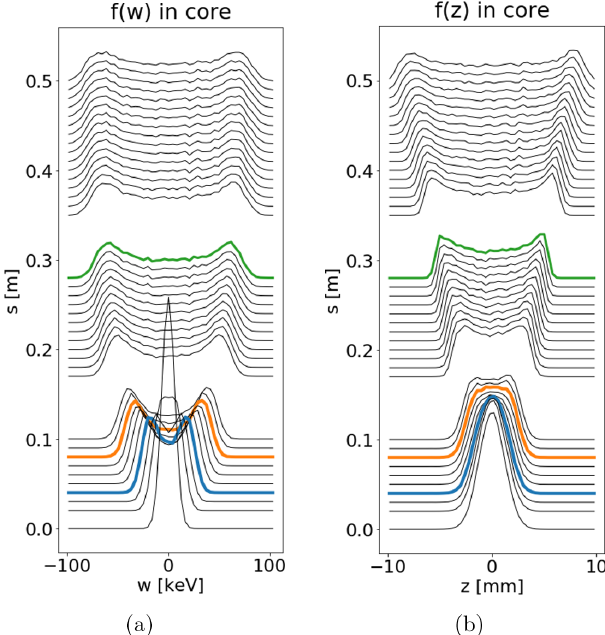
FIG. 5. Evolution of the (a) energy and (b) phase profiles in the 10% 2D core slice for the first 0.5 meters of evolution in the MEBT. The gaps indicate the quadrupole locations. Colored lines highlight the profile at 4 cm, 8 cm and 28 cm.